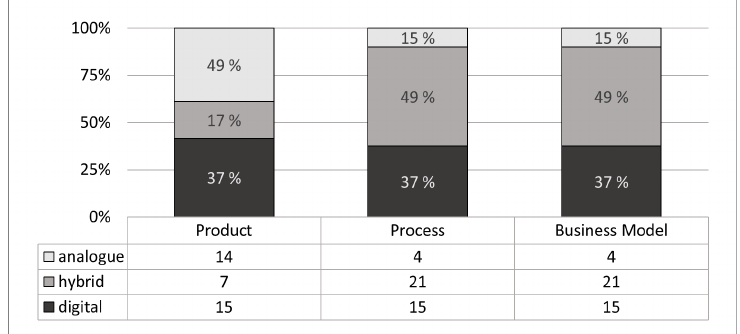
Fig. 2. Levels of digitalization of start-ups and start-up projects of the